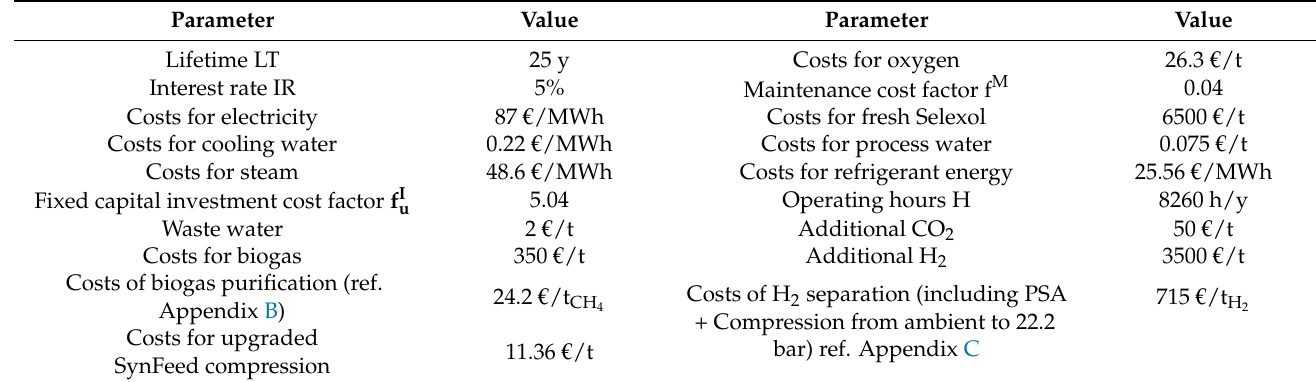
Table 15. Key parameters for techno-economic analysis [17,30,33–36].